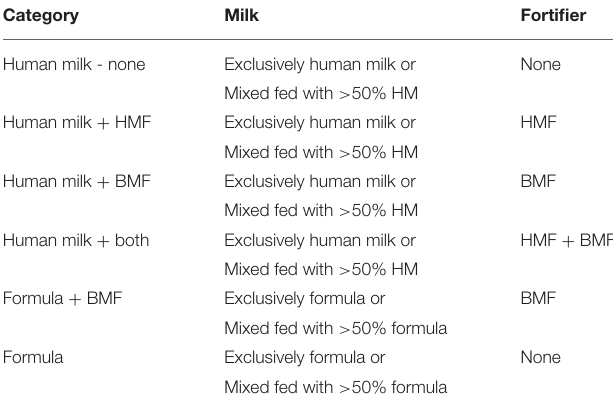
The intercept and slope were set as fixed effects, variance of TABLE 2 | Feeding